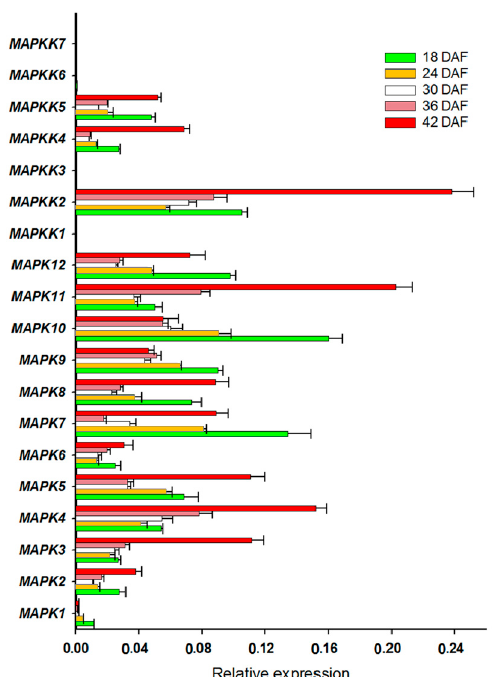
Figure 5. FvMPK and FvMPKK expression profiles in different fruit developmental stages. X-axis is the relative expression, while Y-axis is MAPK and MAPKK genes; 18–42 DAF, five developmental stages of days after flowering.